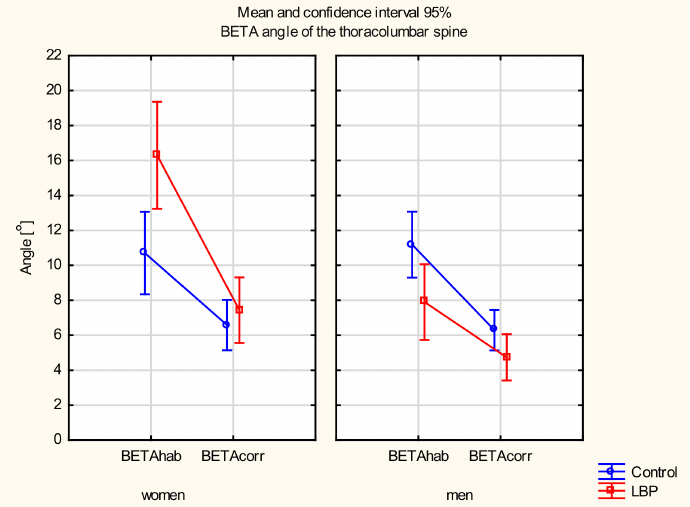
Figure 4. Mean and 95% CI of the BETA angle of the thoracolumbar spine in women and men, in habitual (hab) and corrected (corr) positions, in the control and LBP